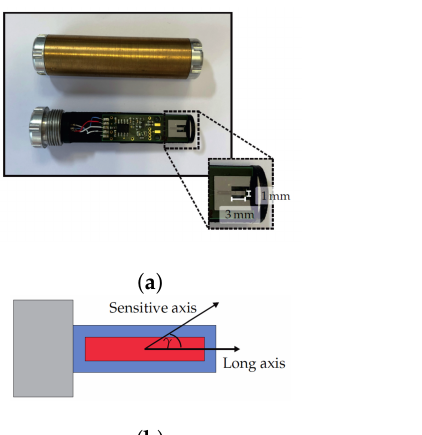
Figure 2. ( a ) Exchange bias ∆ E-effect sensor used in this study. The sensor is based on a cantilever of size 3mm × 1mm. The cantilever is placed on a printed circuit board and connected to a low-noise JFET charge amplifier [19]. The sensor is encapsulated by a brass cylinder for electrical shielding and mechanical protection. ( b ) Visualization of the relationship between the sensitive and the long axis of the sensor. ( c ) Magnitude and phase response of the sensor in the first bending mode applying a magnetic field of b ac = 1 µ T. The sensor has a resonance frequency of f r = 7.712kHz and a bandwidth of bw –3dB =